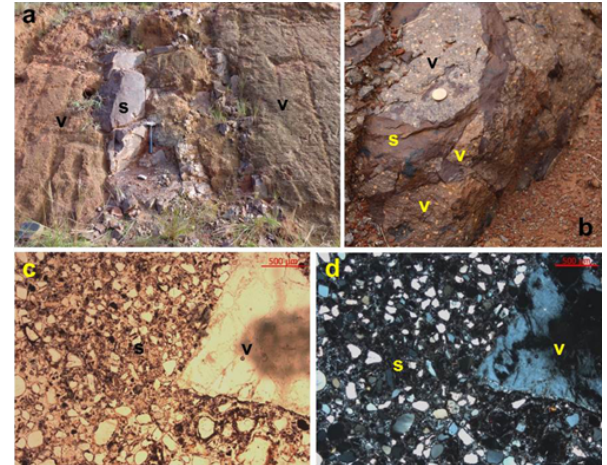
Fig. 4. Peperite from São Jerônimo da Serra: (a, b) photomicro- graphs of the immature and poorly sorted sediment ( c =// polariz- ers; d = X polarizers), (c) clastic dike more than 1m thick, and d angular to sub-angular shaped clasts set in a sandstone matrix. S – sandstone; V – volcanic rock.